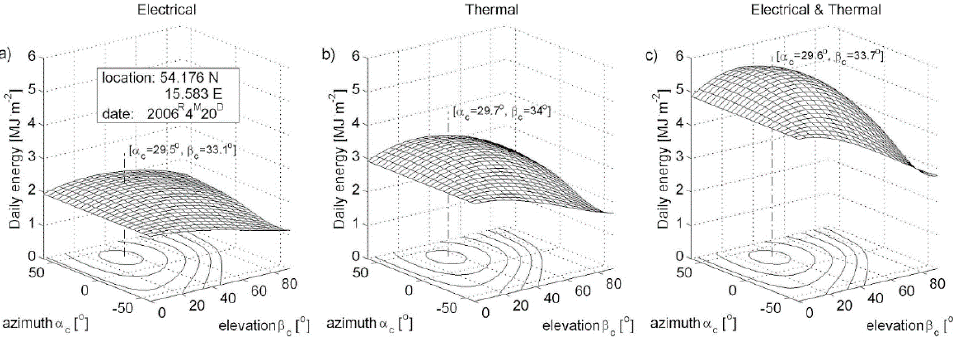
Figure 4. Optimal orientation of the absorber surface on a selected day: ( a ) electrical; ( b ) thermal; and ( c ) electrical & thermal.